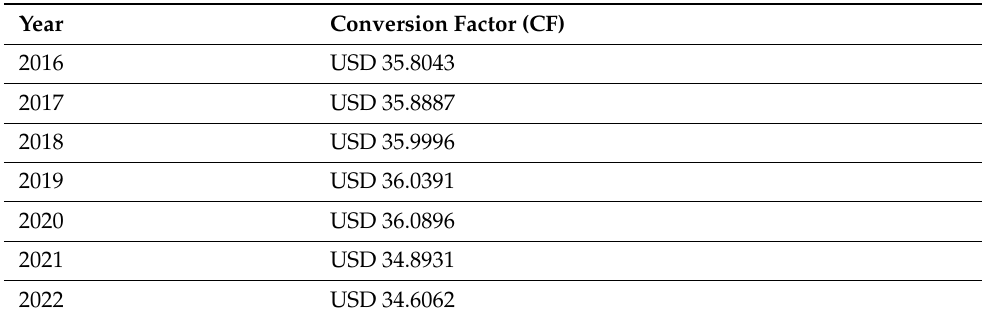
Table 2. Conversion factors (CFs) used in the last 7 years to calculate revenue generated by spine surgeons